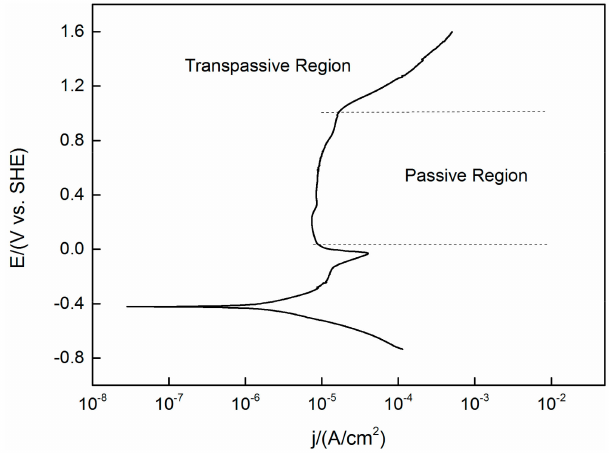
Figure 2. Polarization curve of TC11 alloy in 0.01 M Na 2 SO 4 . Scan in positive direction at 2 mV /